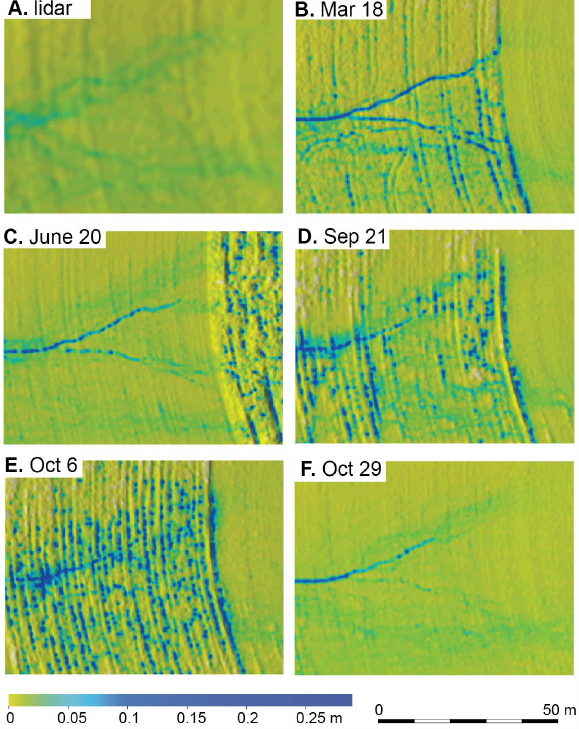
Figure 8: Enlarged area B from Figure 5, with the visible Figure 7: The puddle on the service road (enlarged area C from Figure 5) captured on the orthophoto from Mar 18 (A and B), Jun 20 (C), Oct 06 (D) and Oct 29 (E) with displayed results of overland flow simulations on lidar based DEM (A) and DSMs based on sUAS data collected Mar 18 (B), Jun 20 (C), Oct 06 (D) and Oct 29 (E)